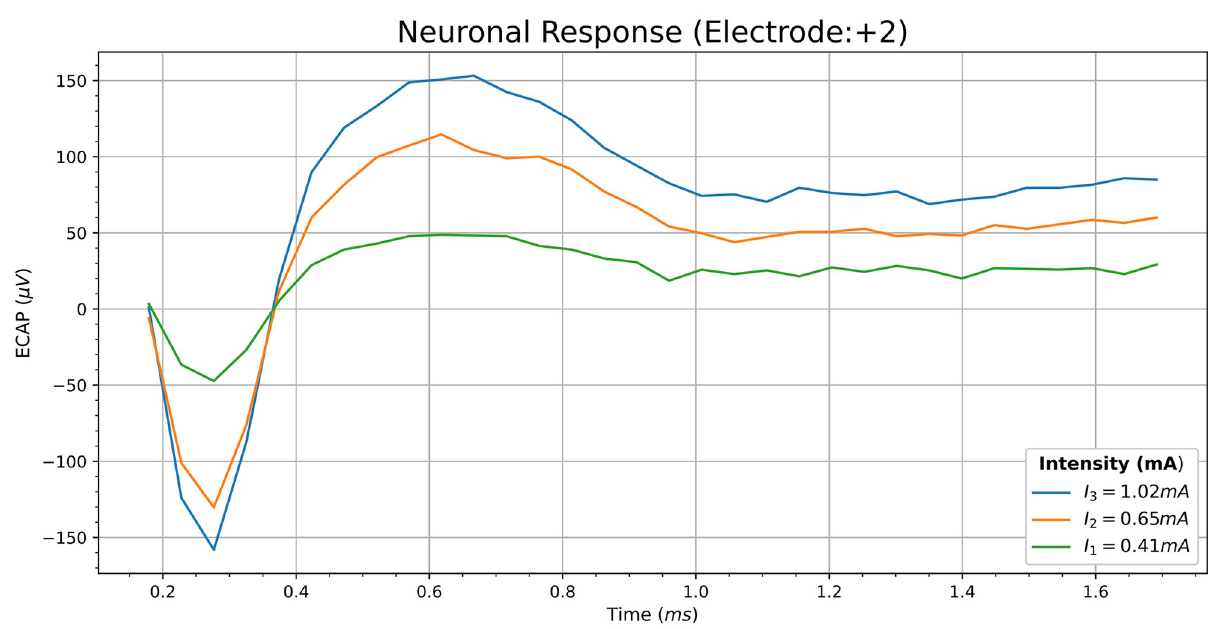
Fig 6. Real ECAPs produced by three stimulation currents. This figure shows the resulting ECAPs, provided by Custom Sound Evoke Potentials software from Cochlear, after the following stimulation currents: I 1 = 0.41 mA (green line), I 2 = 0.65 mA (orange line) and I 3 = 1.02 mA (blue